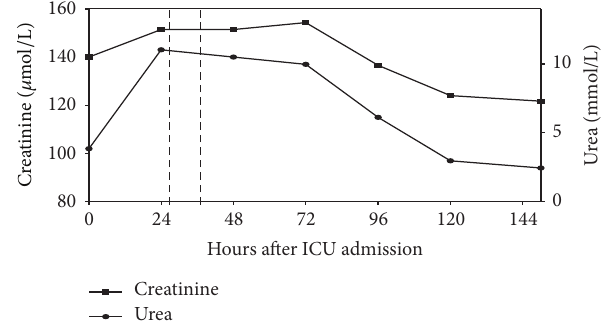
Figure 2: Parameters of renal function over the ICU stay. Adminis- tration of physostigmine is highlighted with vertical lines.